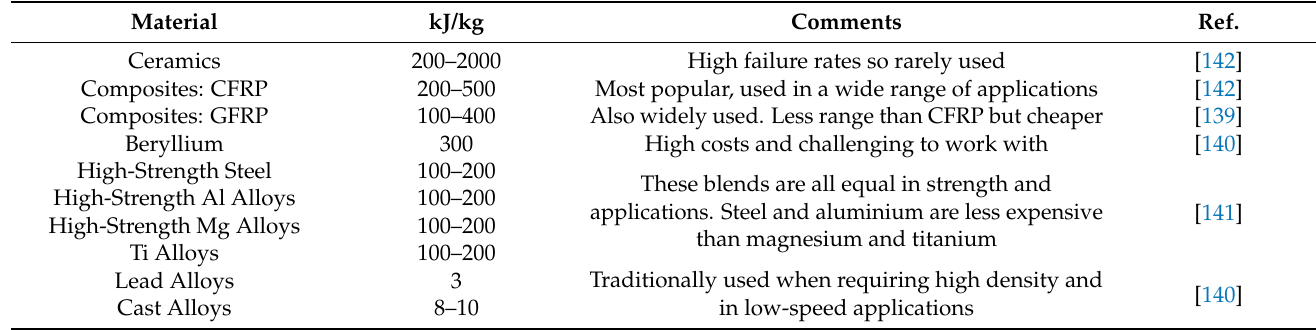
Table 6. Some selected materials for